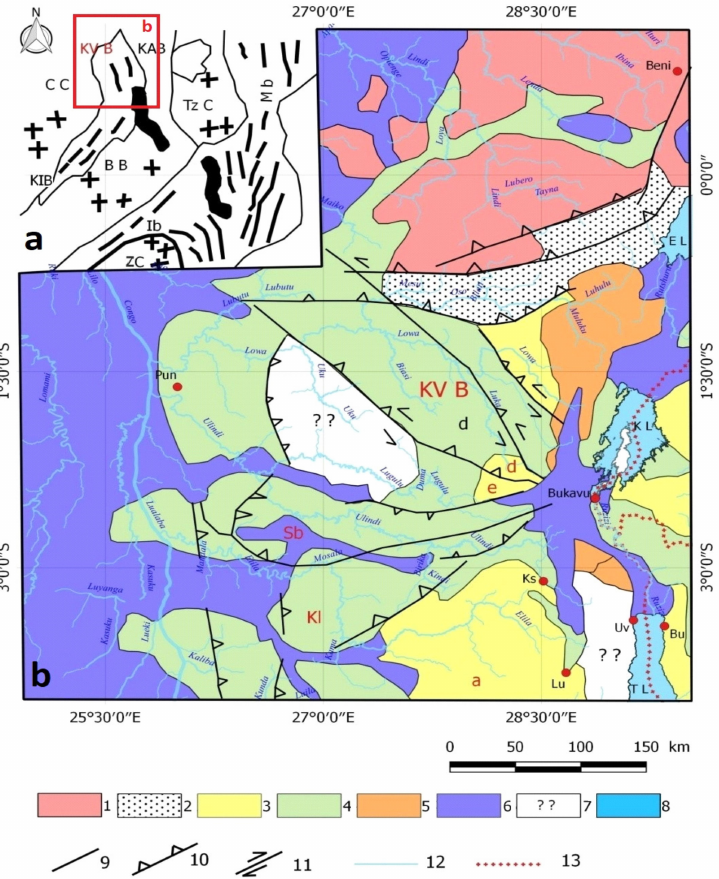
Figure 1. Sketch map of the main formations in the KVB. Legend: ( a ): CC—Congo Craton,